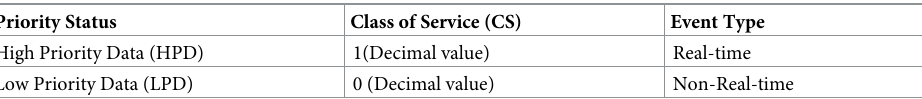
Table 1. Data prioritization using the class of service